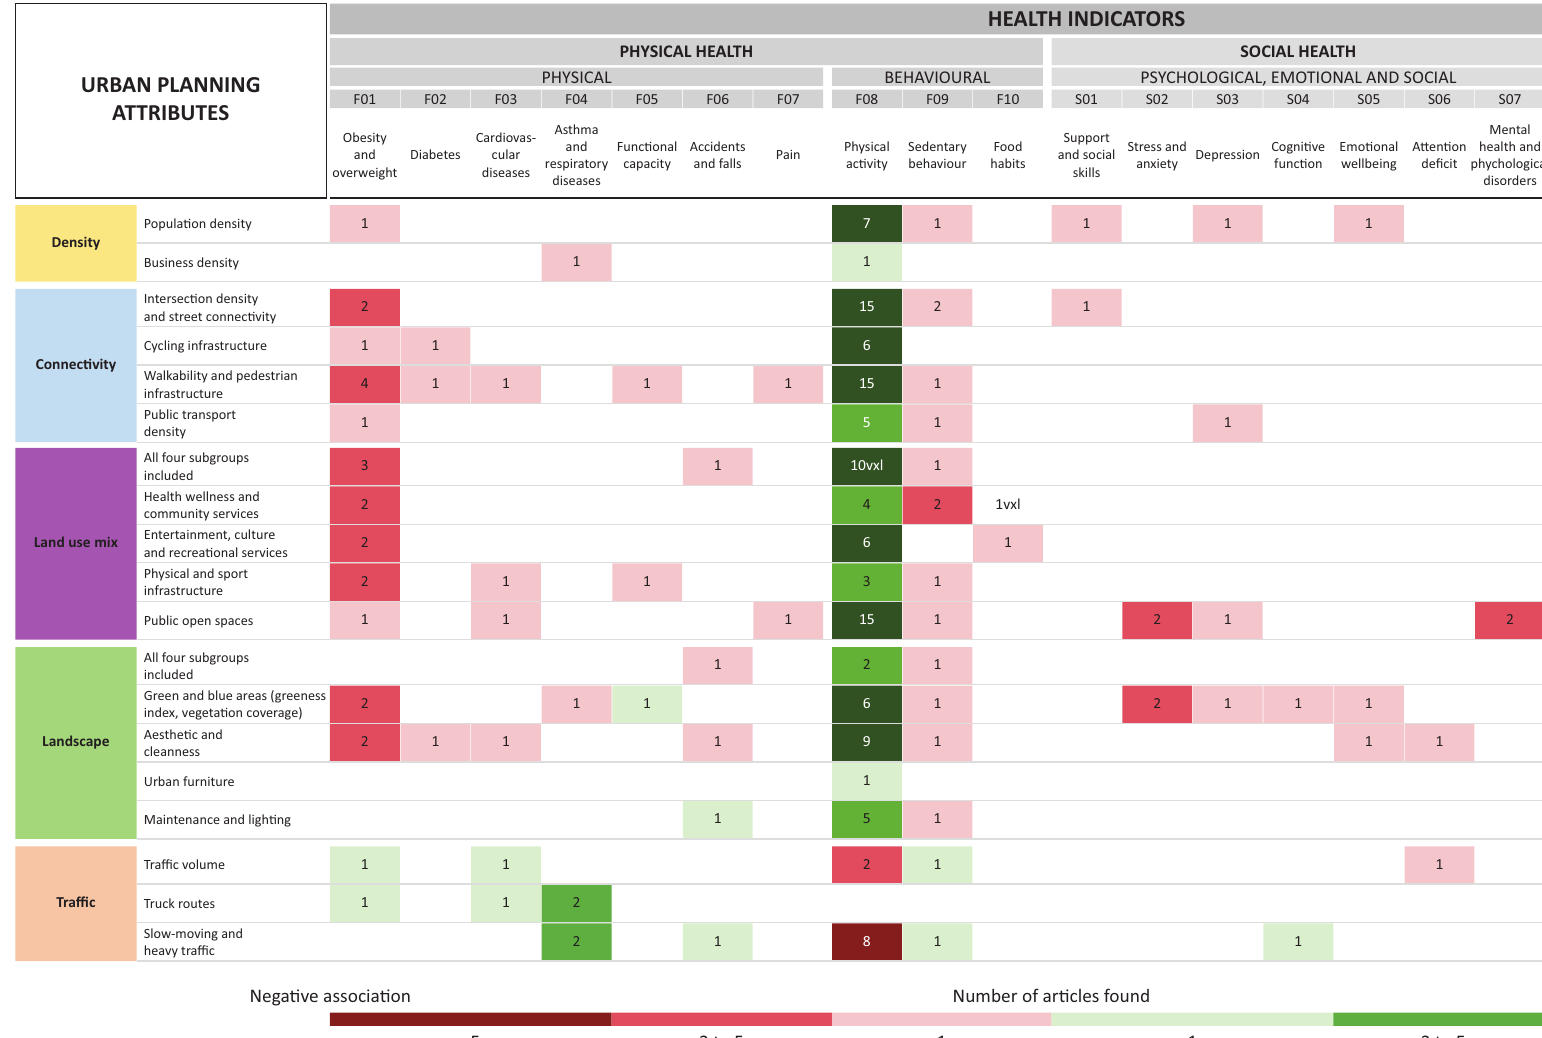
Figure 5. The urban and health association matrix for urban planners: Understanding associations between urban planning attributes and health outcomes.